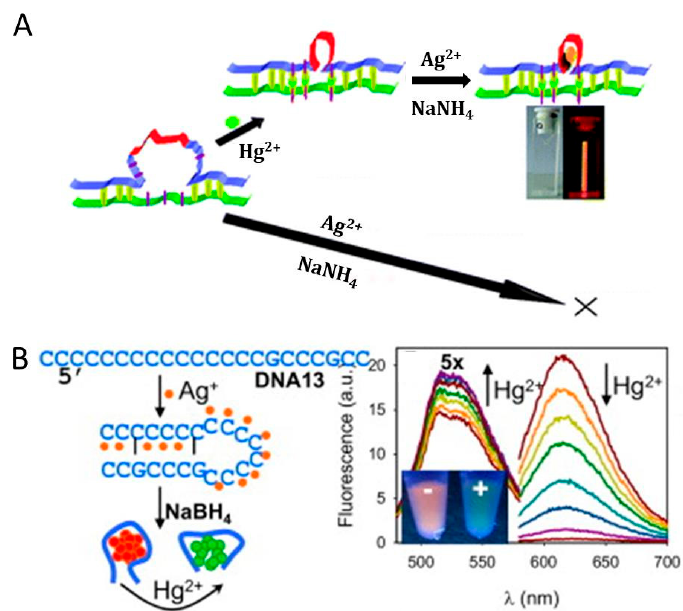
Figure 6. Schematic representation for ( A ) A turn-on Hg 2 + sensor that based on DNA-templated F-AgNCs. Reprinted with permission from Ref. [78]. Copyright 2011, Royal Society of Chemistry. ( B ) A ratiometric Hg 2 + sensor that based on dual emissive DNA-templated F-AgNCs. Reprinted with permission from Ref. [80]. Copyright 2013, Elsevier B.V.